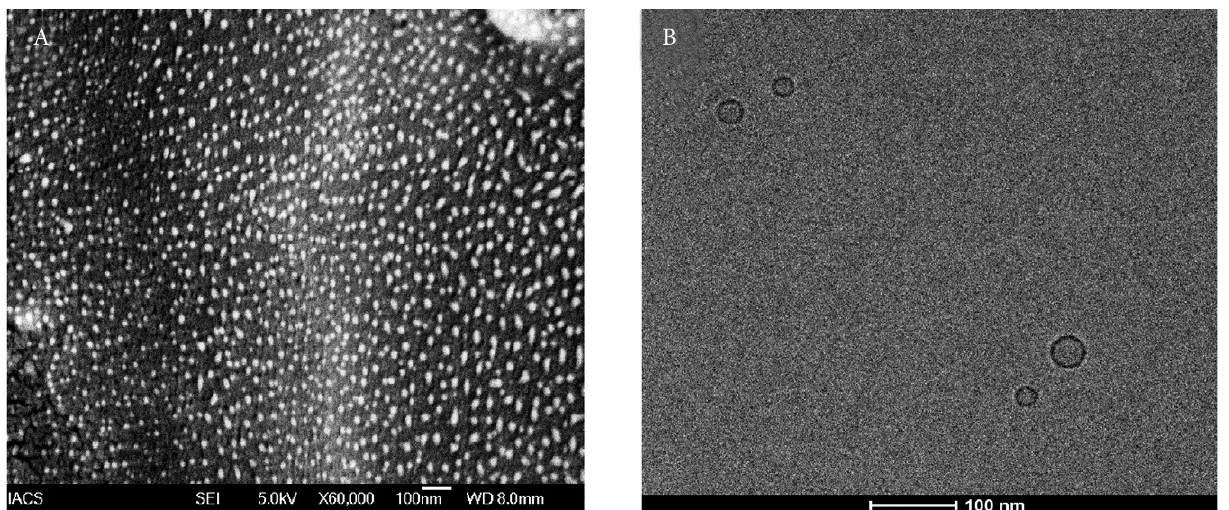
Fig. 1 . (A) Field emission scanning electron microscopy (FESEM) image of optimized lomustine incorporated lipid nanostructures (LNL-2). (B) Cryo-transmission electron microscopy (Cryo-TEM) image of LNL-2